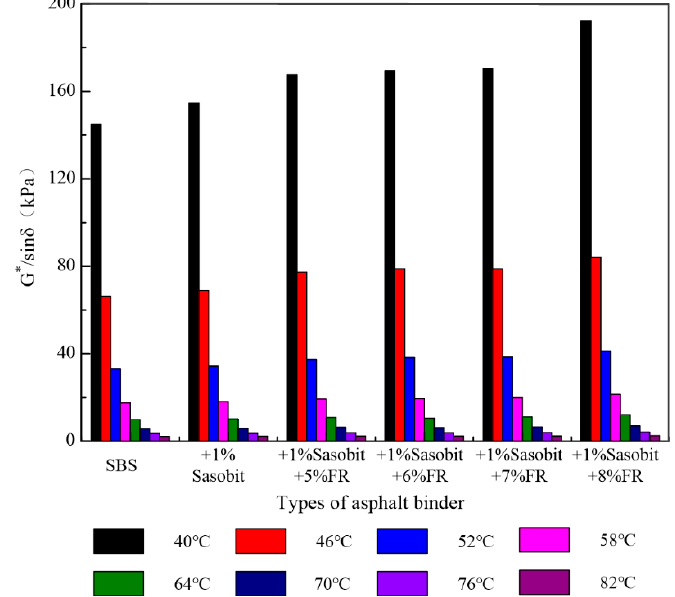
Figure 4. Results of the dynamic shear rheological test of rolling thin film oven tested (RTFOT) aged asphalt binder.